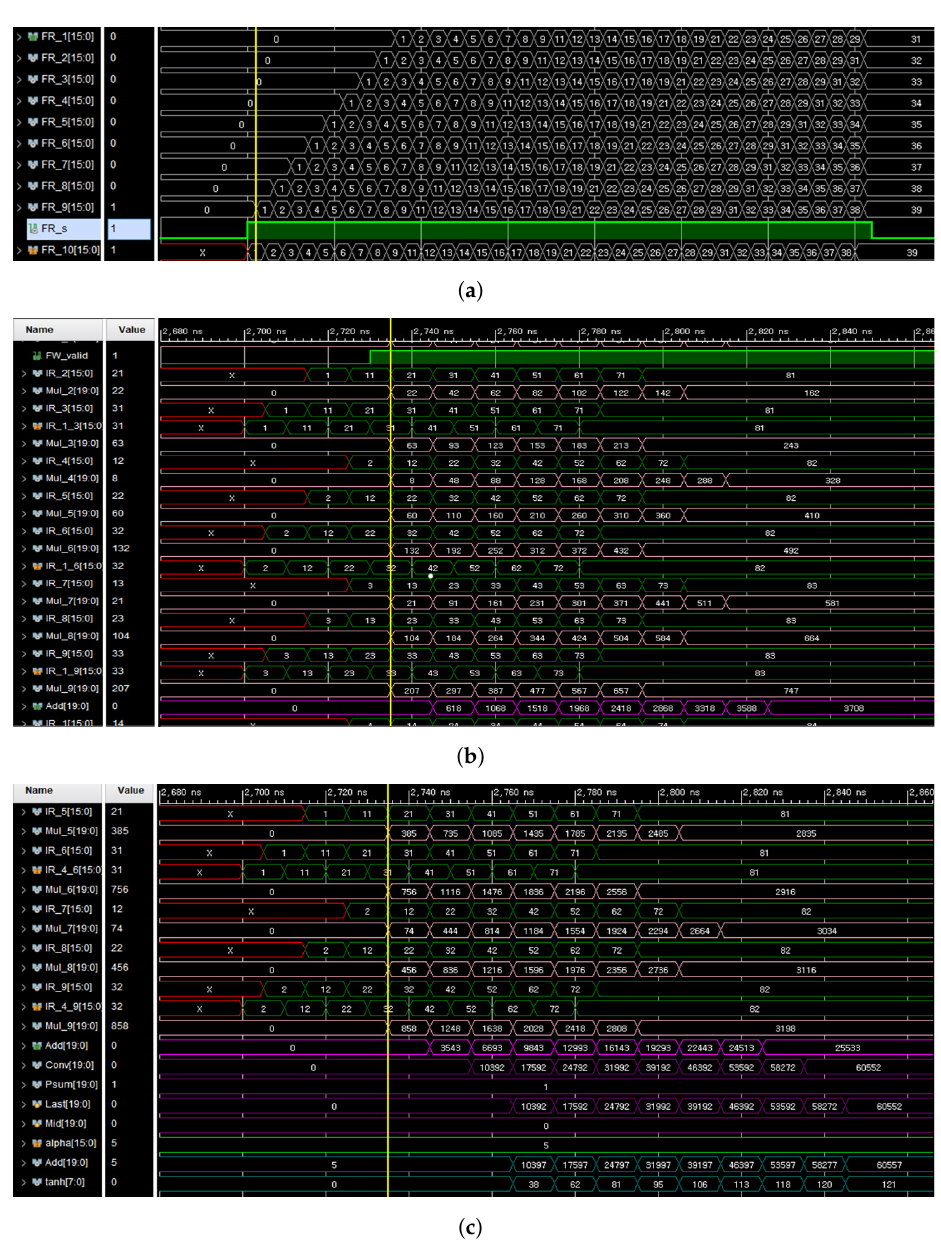
Figure 11. Simulation results for the hardware; ( a ) input data, ( b ) multiplication output, ( c ) adder, convolution, partial sum, post, and tanh